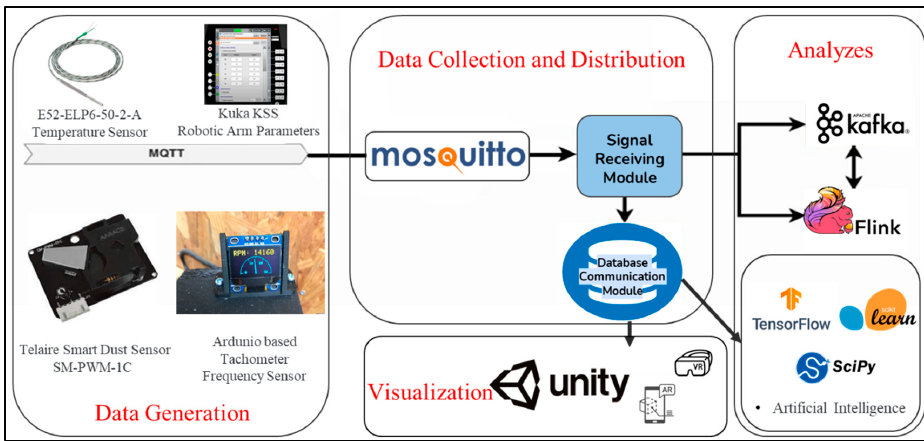
Figure 7. The visual representation of the system architecture.